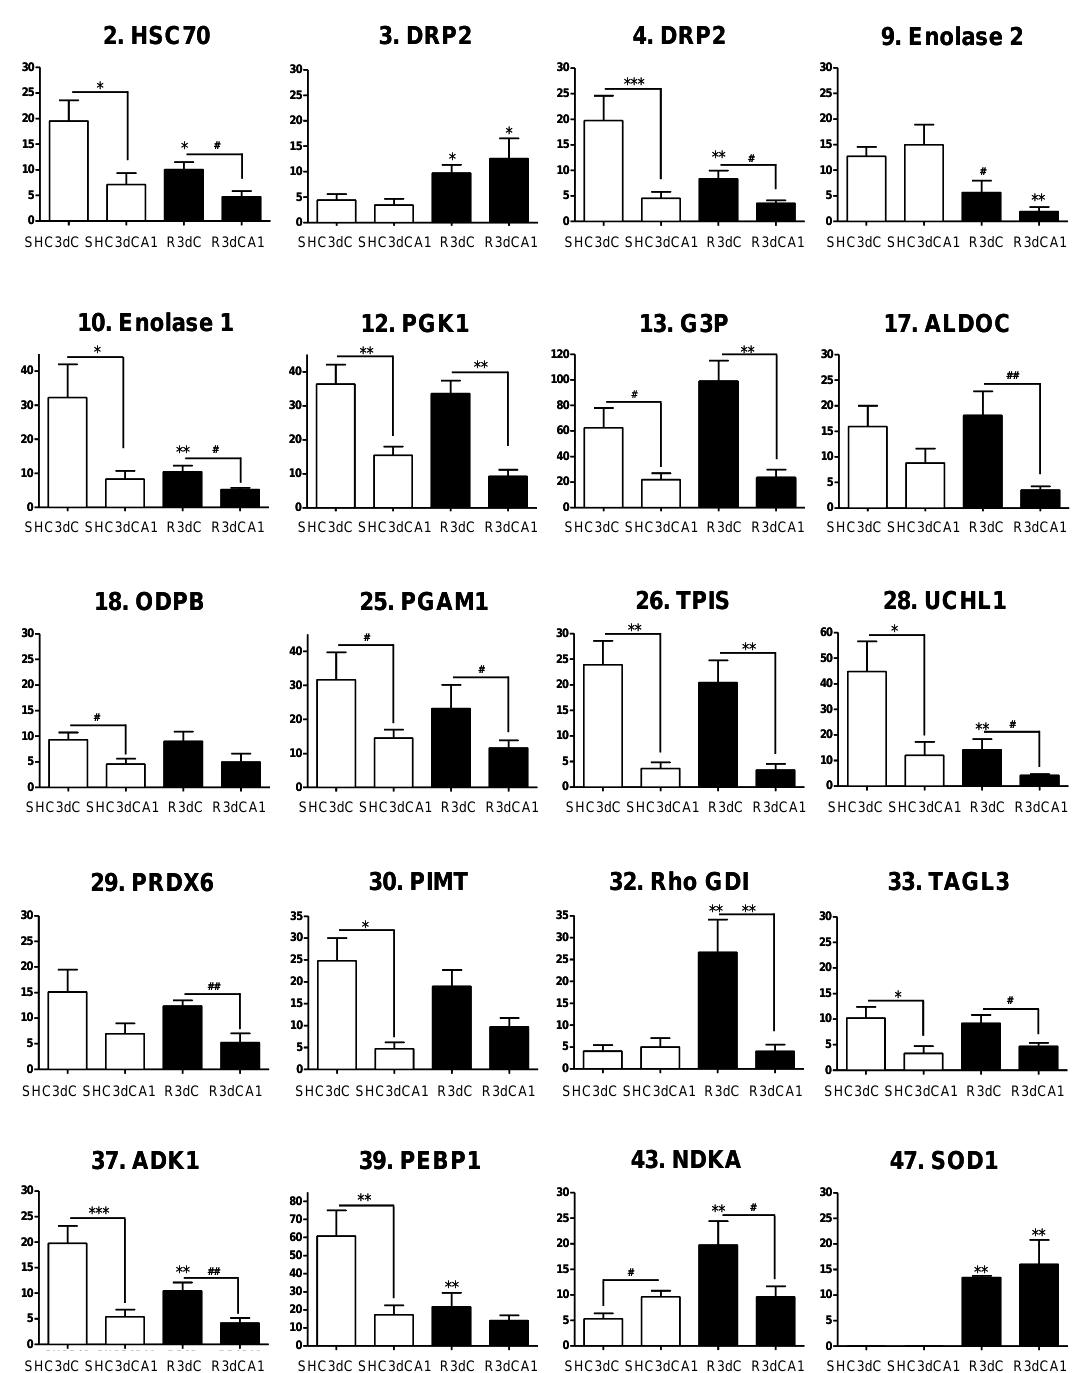
Figure 4. Levels and statistical analysis of identified 4E-BP2-interacting proteins with significant differential changes. Bar graphs show the 4E-BP2-associated protein levels in control (SHC3d) and ischemic samples (R3d) from the cerebral cortex (SHC3dC and R3dC) and hippocampal CA1 region (SHC3dCA1 and R3dCA1). Data are represented as mean of n = 4 independent samples from 2-D DIGE experiments. Error bars indicate SE. Scheme 0. ** p < 0.01; *** p < 0.001) or by Student’s t-test (# p < 0.05; ## p < 0.01), after significant ANOVA (* p < 0.05), compared with their respective control, or between the cerebral cortex and CA1 samples (indicated by lines). The vertical axis indicates the quantification values of the spot intensity in arbitrary units. Graphs are numbered and named according to the proteins listed in Table 1.